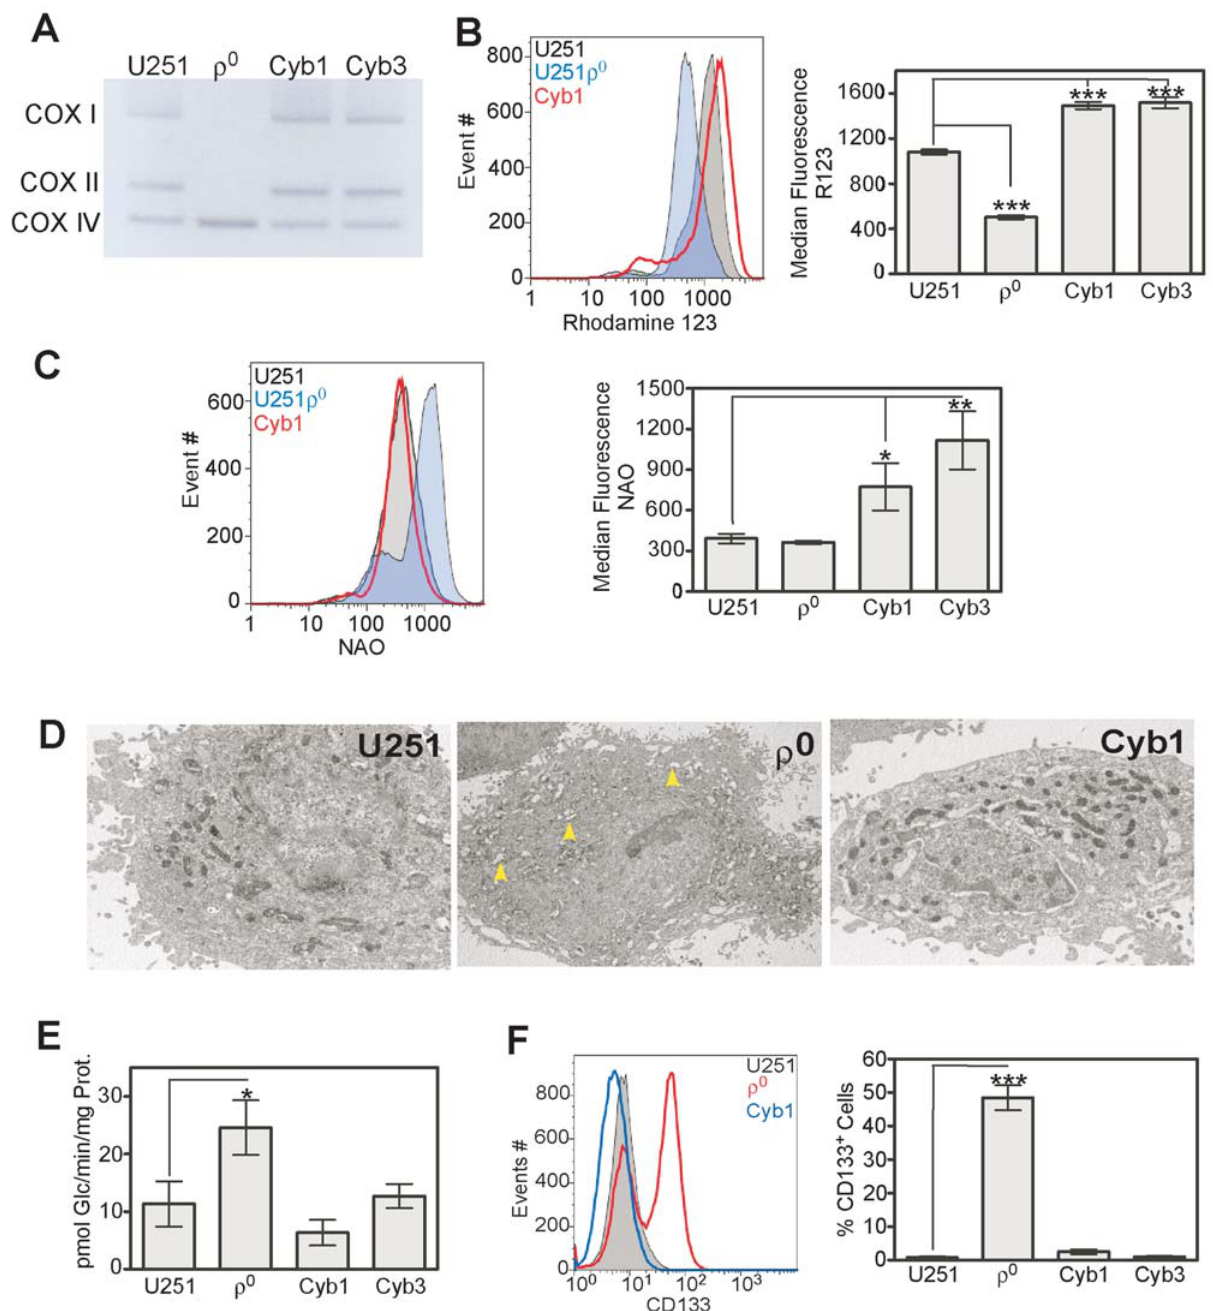
Figure 6. Characterization of U251 transmitochondrial cybrids. A ) Genomic DNA was isolated from control, mtDNA-depleted and transmitochondrial cybrid cells, and mtDNA-encoded genes including COX-I and COX-II were amplified by PCR. COX IV serves as a nuclear DNA- encoded control. The PCR products were electrophoresed on 1.5% agarose gel and then visualized by EtBr staining. A representative result of three independent experiments is shown. B) Representative histograms of R123 fluorescence for U251, U251 r 0 and cybrids cells (left); average R123 fluorescence profiles (right). C) Representative histograms of NAO fluorescence for U251, U251 r 0 and cybrids cells (left); average NAO fluorescence profiles (right). D) A Representative electron transmission microscopy photographs comparing U251, U251 r 0 and cybrids cells (Magnification X6000). Arrowhead showing that U251 r 0 cells have smaller mitochondria with large intramembraneous spaces. E) Glucose transport activity for the parental and r 0 cells. Results are given as means 6 SD of 3 separate experiments. F) Representative histograms of flow cytometry CD133 fluorescence for U251, U251 r 0 and cybrids cells (left). Percentage of CD133 expressing cells (right). Results are given as means 6 SD of 5 separate experiments.